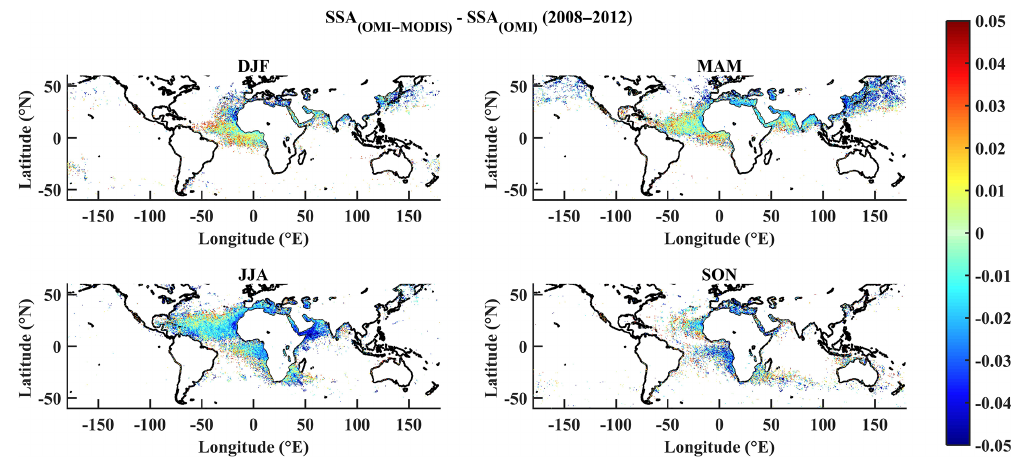
Figure 2. Spatial distribution of the difference in SSA retrieved by OMI–MODIS and SSA retrieved by OMI, both at 388nm. When the OMI–MODIS SSA value was found to be invalid, the difference was also considered to be invalid.